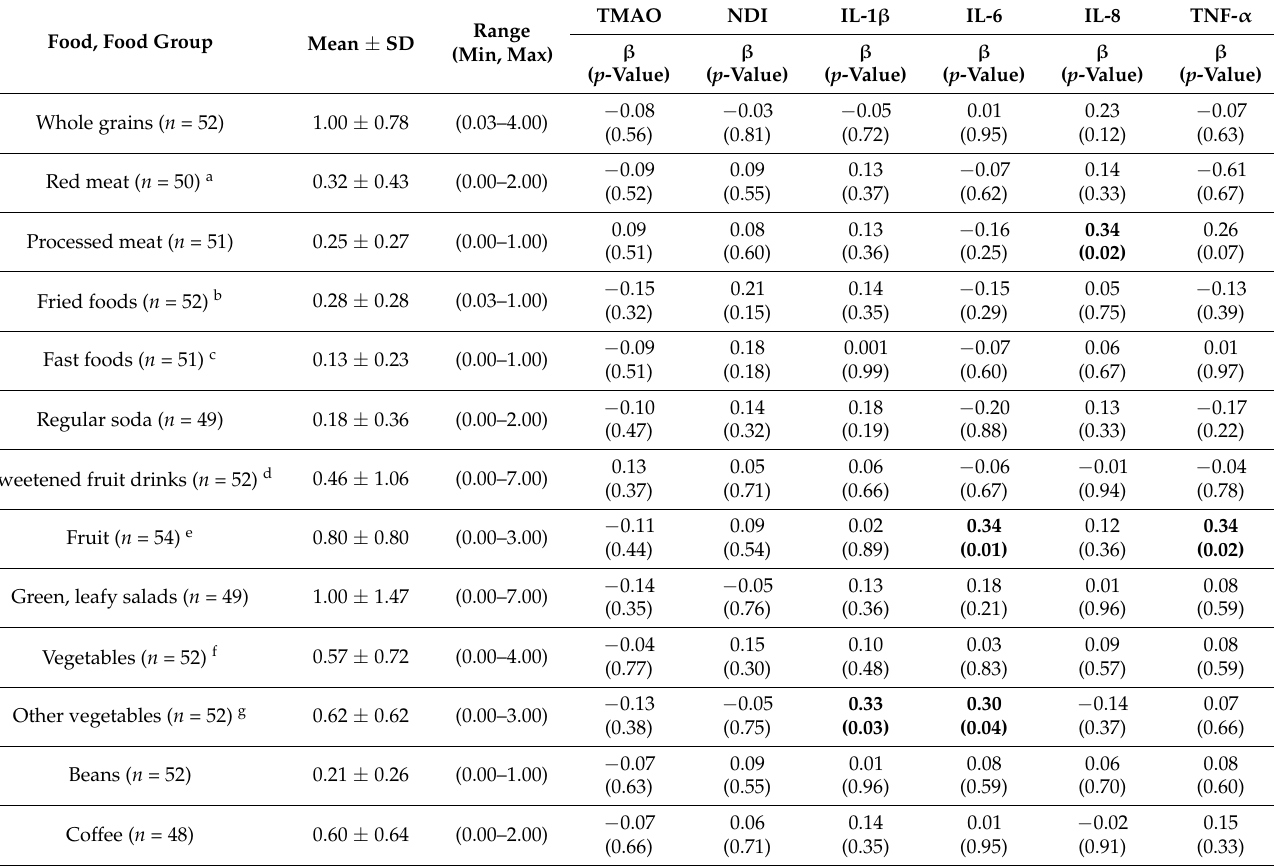
Table 4. Multivariate associations between daily consumption of specific foods and food groups and trimethylamine-N- oxide (TMAO) levels in participant serum, neighborhood deprivation index (NDI), and inflammatory markers, adjusted for ASCVD 10 y risk score and